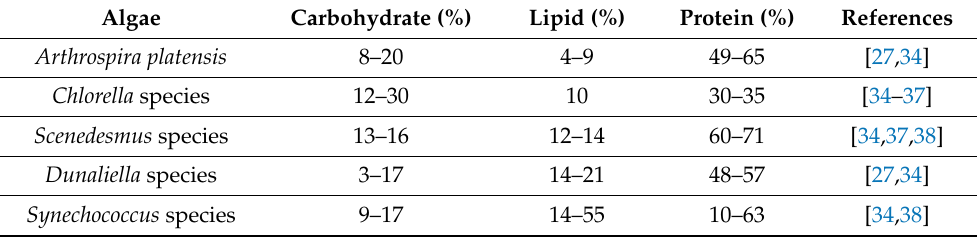
Table 3. Protein, carbohydrate, and lipid constituents’ range of selected microalgae.